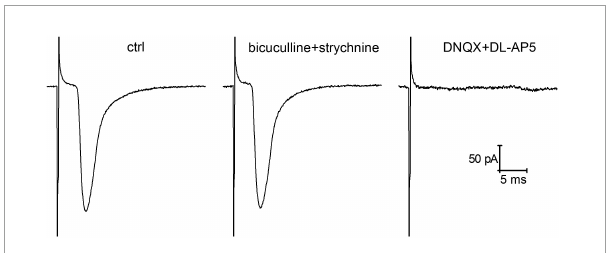
FIGURE1 Glutamatergic evoked glutamatergic excitatory postsynaptic currents (eEPSCs) recorded in cultured hippocampal neurons following local extracellular electrical stimulation of single presynaptic axon. The represented traces of eEPSCs (averaged of 50 sweeps) demonstrate the action of GABA (gamma-aminobutyric acid)- and glycinergic neurotransmission blockers (1 µ M strychnine and 10 µ M bicuculline) and the effects of ionotropic glutamate receptor antagonists (10 µ M DNQX and 10 µ M DL-AP5) on the amplitude of eEPSCs.